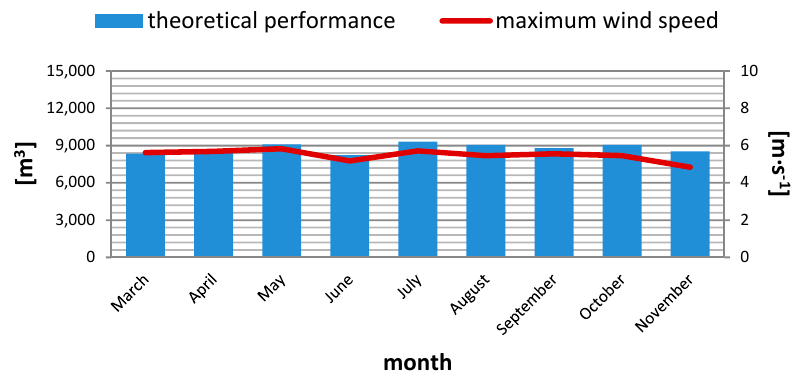
Figure 13. E ffi ciency of the pulverization unit of the aerator in Figure 13. Efficiency of the pulverization unit of the aerator in 2018.